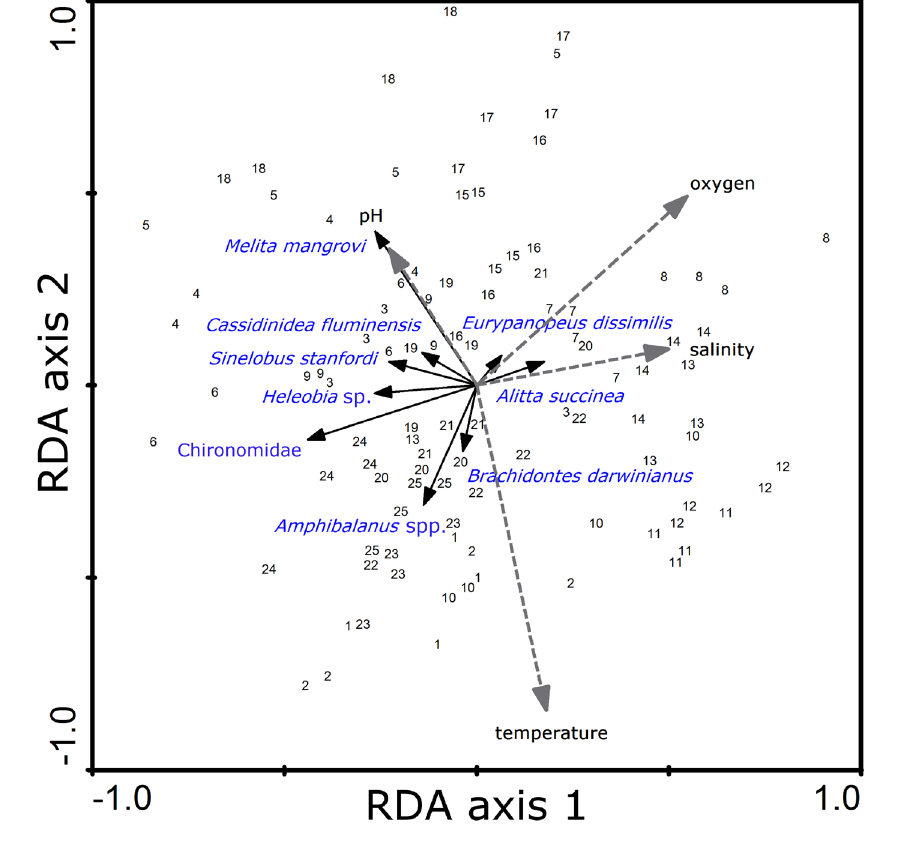
Figure 7. Ordinal diagram of the partial Redundancy Analysis (RDA) showing the relationship between the densities of the macrofauna benthic species associated to Mytilopsis leucophaeata and water quality variables. Samples were labelled by month, wherein number one represents the first sampling month (i.e. March 2016), and